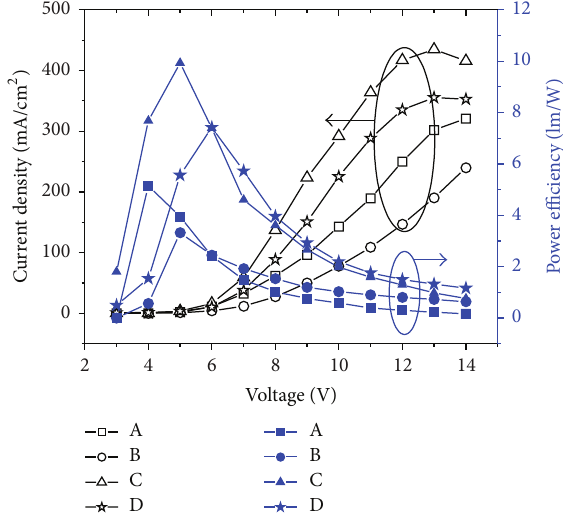
Figure 3: The current density-voltage-power efficiency characteris- tics of four organic devices (device A, B, C and D).